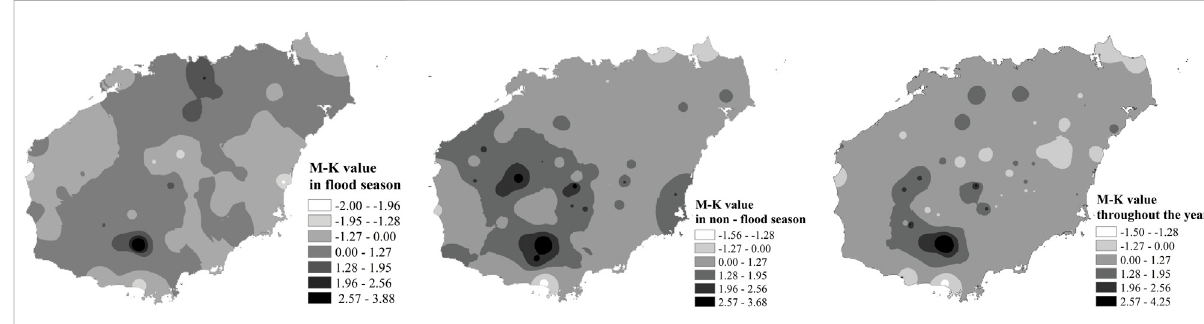
FIGURE 5 Spatial and temporal distribution of drought and fl ood trends in Hainan